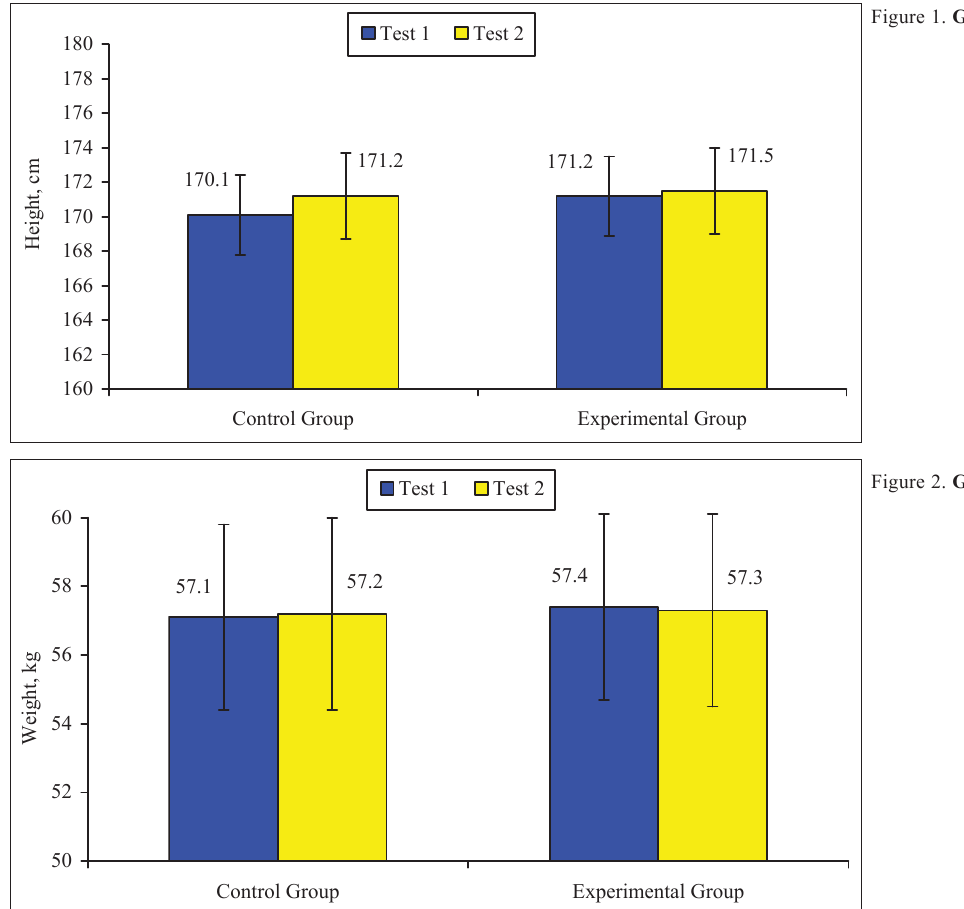
Figure 1. Girls’ height ( xSx ±